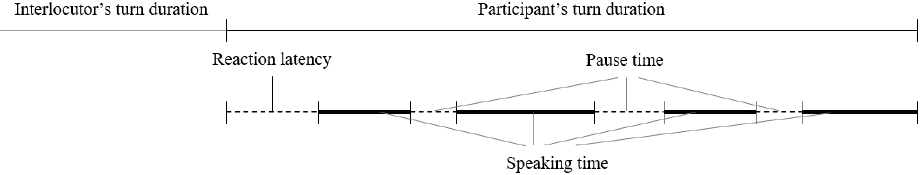
Figure 5. The visualization of the meaning of each